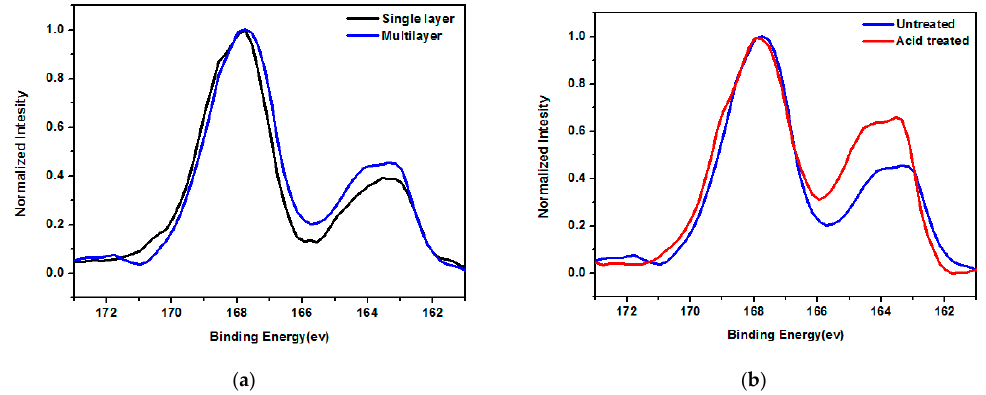
Figure 6. The S (2p) XPS spectra of ( a ) single layer and multilayer film and ( b ) untreated and acid treated film.